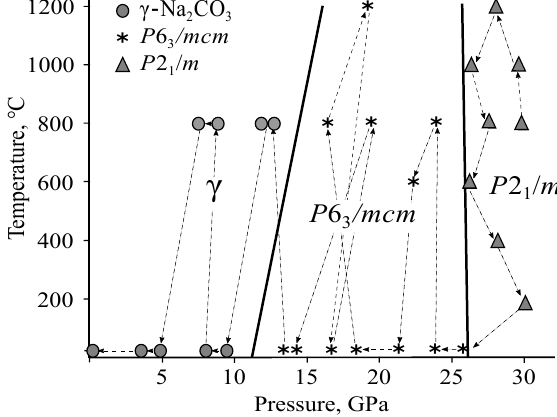
Figure 4. Phase diagram of Na 2 CO 3 according to MA